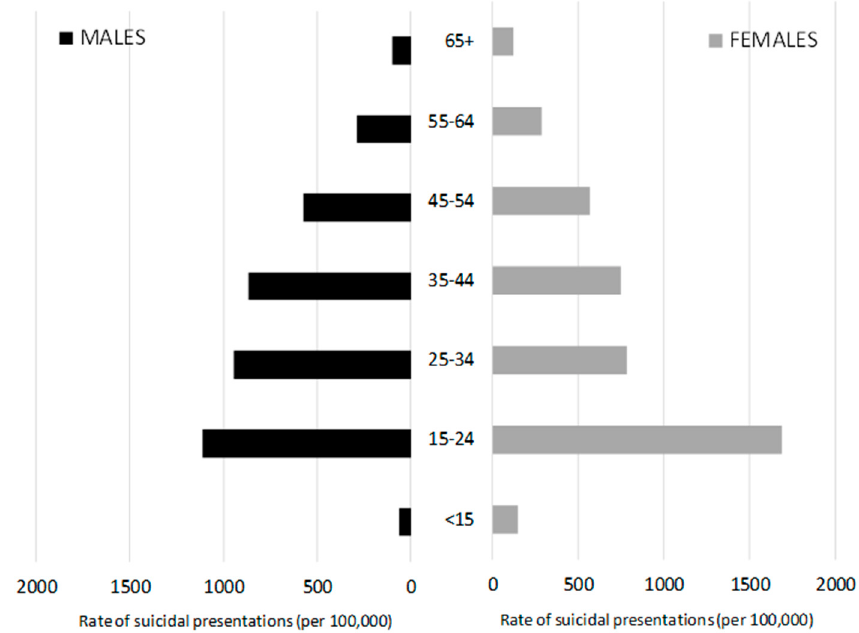
Figure 1. Age-specific rates of suicidal presentations by males and females, 2009–2018.